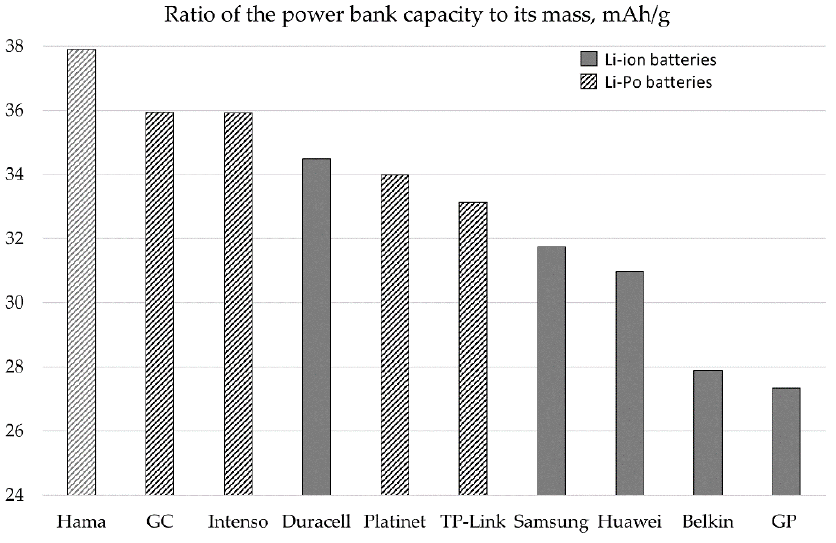
Figure 12. Ratio of the power bank capacity to its mass, mAh/g.